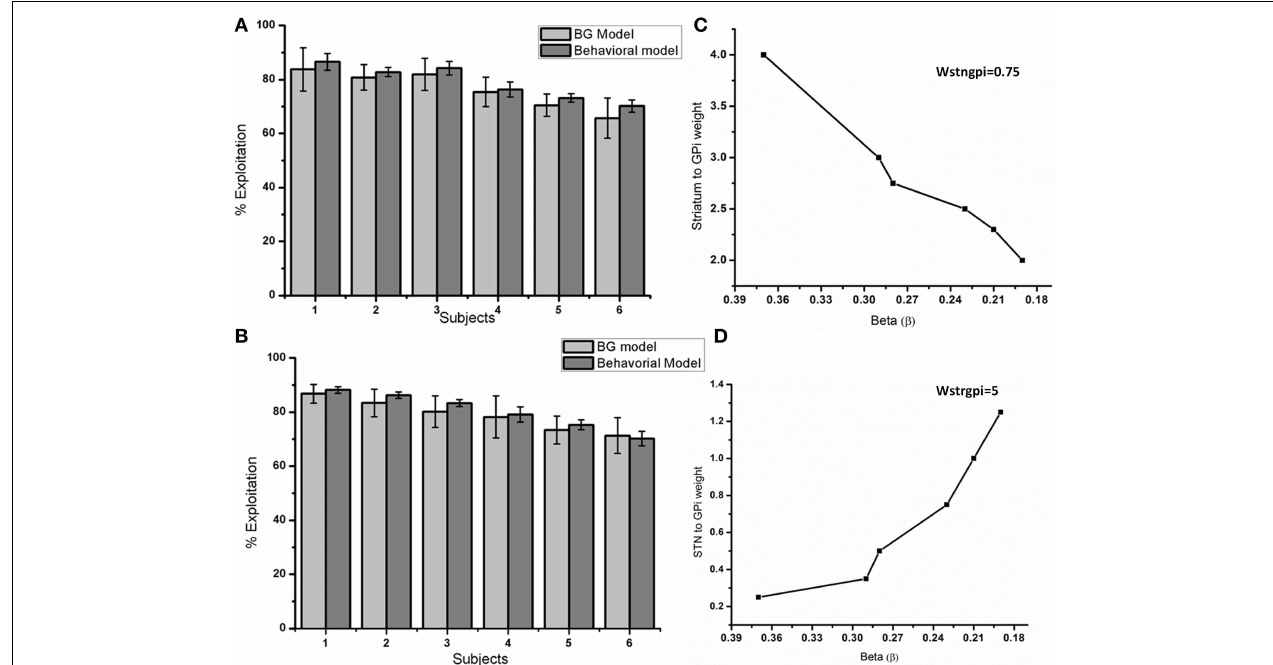
weights (w Str → GPi ) with a constant w STN → GPi value ( = 0.75) used to attain (A) are shown in (C) . (B) Y axis represents percentage exploitation and X axis represents a subject which is a specific beta value ( β ) in behavioral model and the IP weight (w STN → GPi ) in the BG model. The relationship between beta’s ( β ) of the behavioral model and IP weights (w STN → GPi ) of BG model with a constant w Str → GPi value of ( = 5) used to attain (B) are shown in (D)